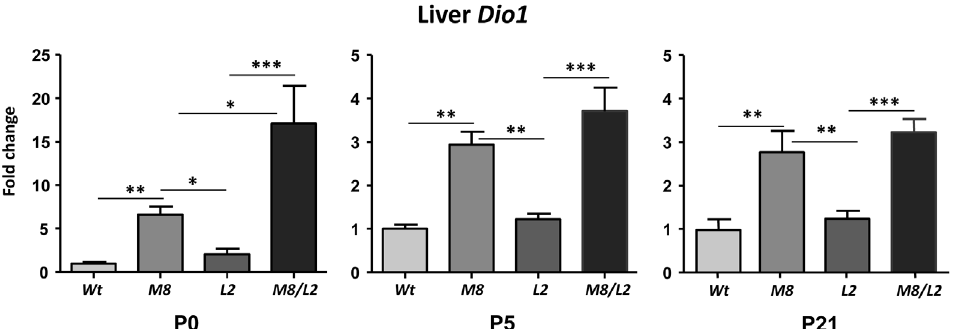
Figure 4. Type 1 deiodinase ( Dio1 ) expression (mean ± SE) in the liver. Wt = wild type mice; M8= Mct8KO ; L2= Lat2KO ; M8L2= Mct8Lat2KO . Measurements were by qPCR, and the data expressed relative to 18S RNA. Note the different scale for the P0 data with respect to P5 and P21. Significance of differences was calculated by one way ANOVA and the Tukey posthoc test. Only relevant significant comparisons are indicated. ** P , 0.01. *** P , 0.001. P5, P21: postnatal days 5 or